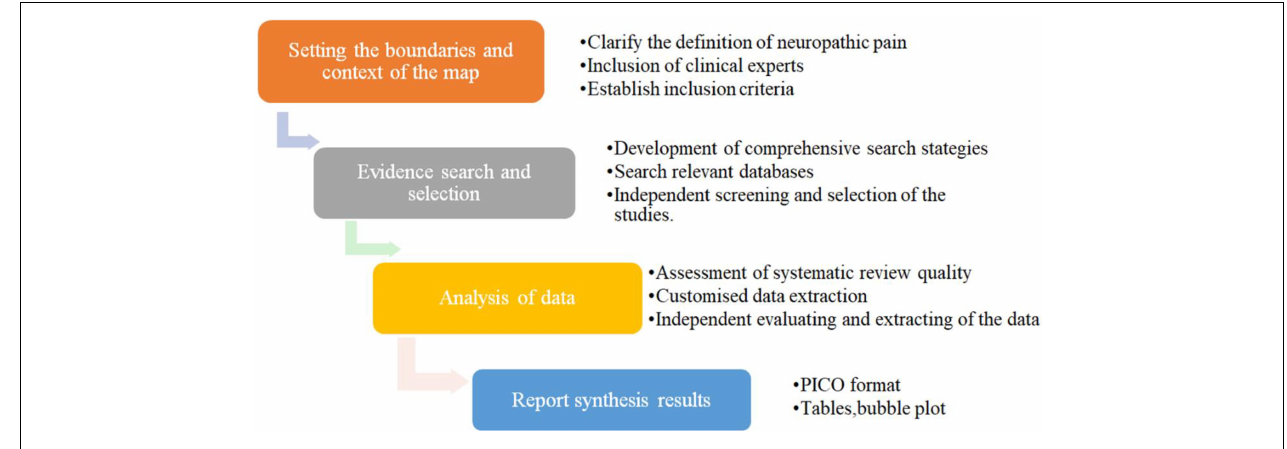
FIGURE 1 | Core tasks performed to map